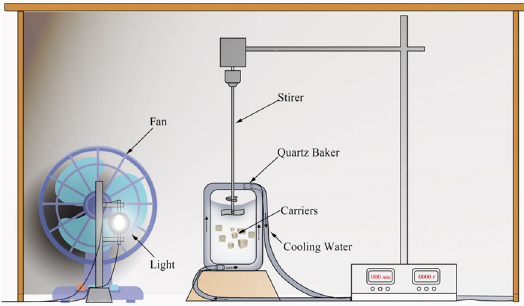
Figure 3. Schematic diagram of equipment.